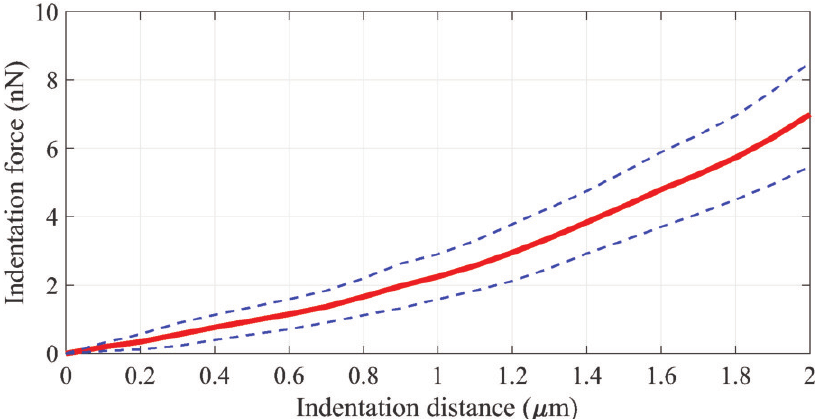
Figure 10. The average pre-processed experimental F-D curves. Dashed lines present the standard deviation of the forces.